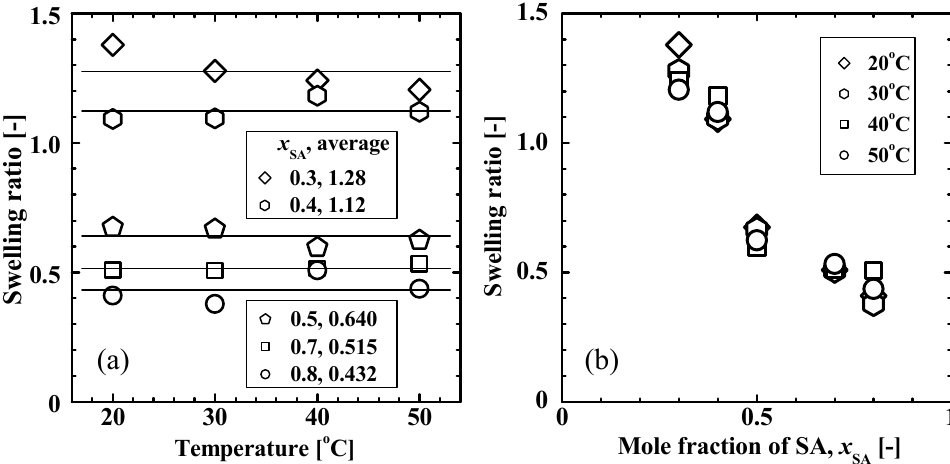
Figure 2. Swelling ratio of poly(SA- co -MPGA) hydrogels at 20–50 °C as a function of ( a ) temperature and ( b ) the mole fraction of SA, x SA , in the pre-gel solution. The solid horizontal lines in ( a ) show the average swelling ratio at 20–50 °C.